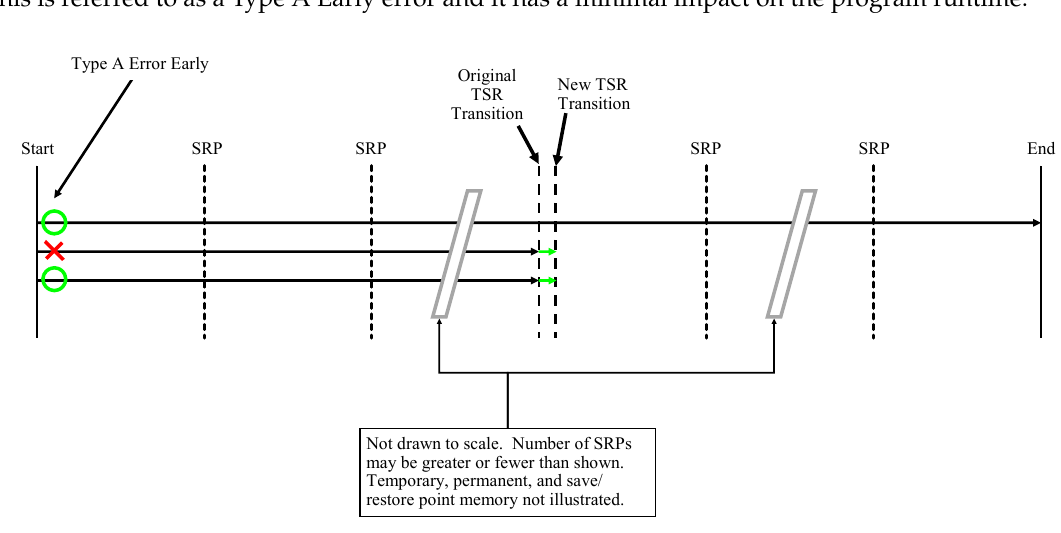
Figure A7. AHR MIPS TMR Type A Early error timing